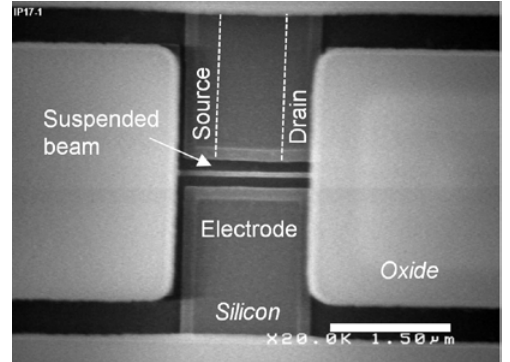
Figure 11. The scanning electron microscope (SEM) view of the fabricated in-plane resonant suspended gate field-effect-transistor (IP RSG-FET)